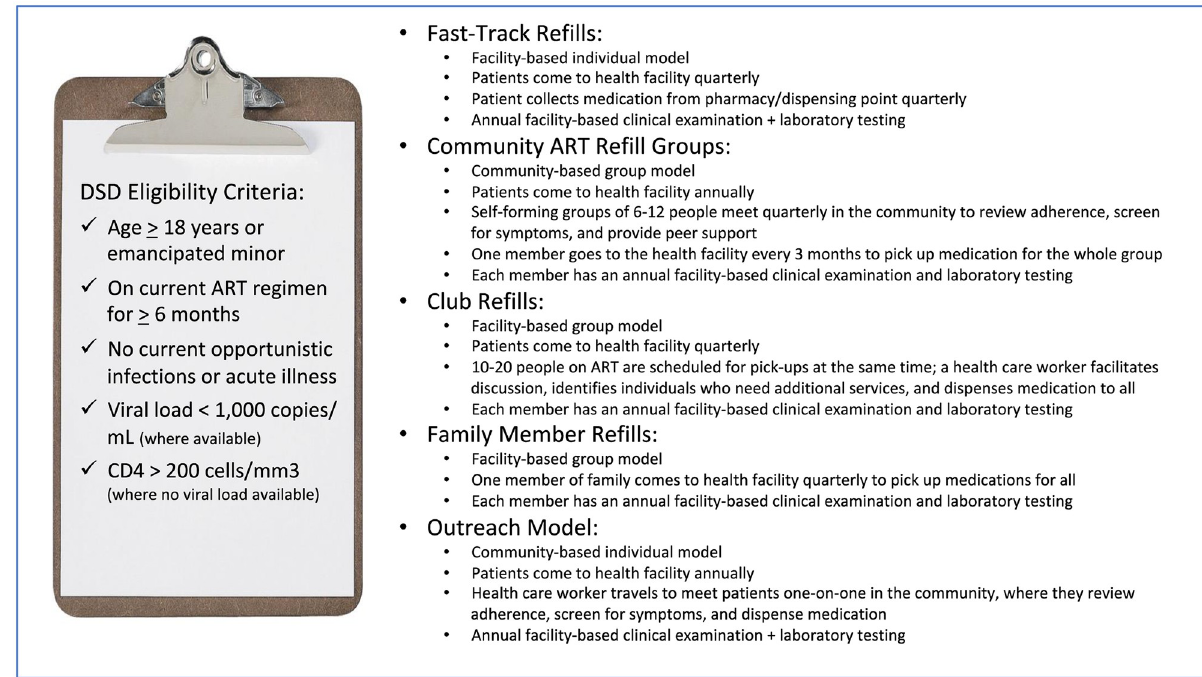
Fig 1. Zimbabwe’s five differentiated service delivery